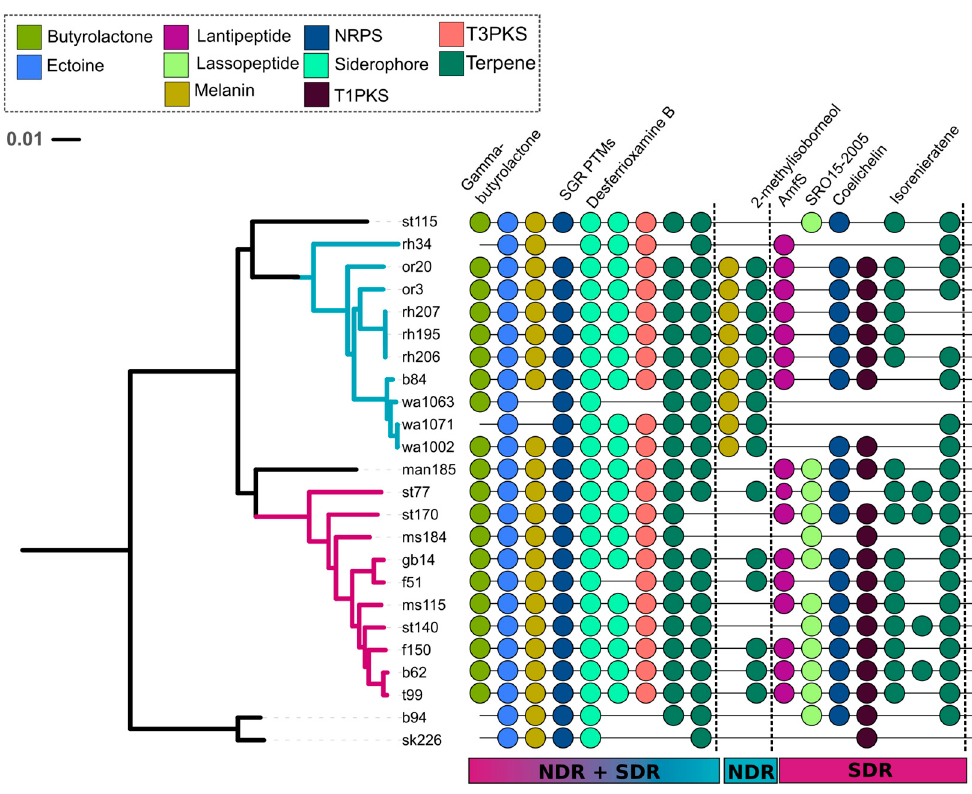
Figure 6. A total of nine core (i.e., conserved in ≥ 80% of genomes) SMGCs were found in both NDR and SDR. The NDR clade had 11 core SMGCs and the SDR clade had 15 core SMGCs. The tree reflects phylogenetic relationships between Streptomyces sister-taxa genomes and was constructed from multiple whole genome alignments (see Figure 1). Scale bar represents nucleotide substitutions per site. Tree branches are colored according to clade affiliation. Core orthologous SMGCs (depicted by colored circles) were determined using the antiSMASH [32] MIBiG annotation pipeline or were defined using our annotation-independent approach (see Materials and Method). Colors correspond to SMGC class (see legend), and natural product annotations are labeled if available.